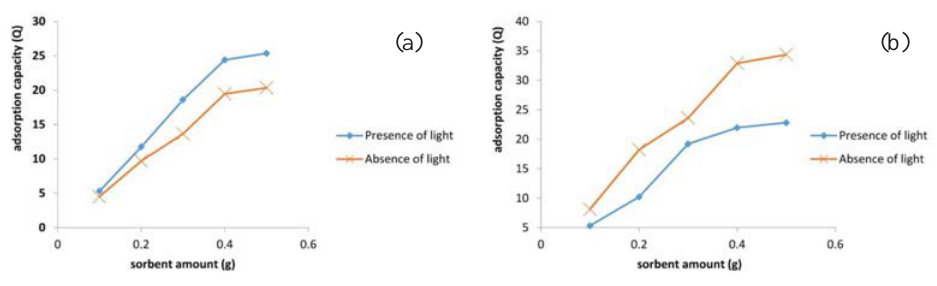
Fig. 7. The effect of sorbent amount of nanocomposites (a) Nd-TiO cadmium ions in presence and absence of light